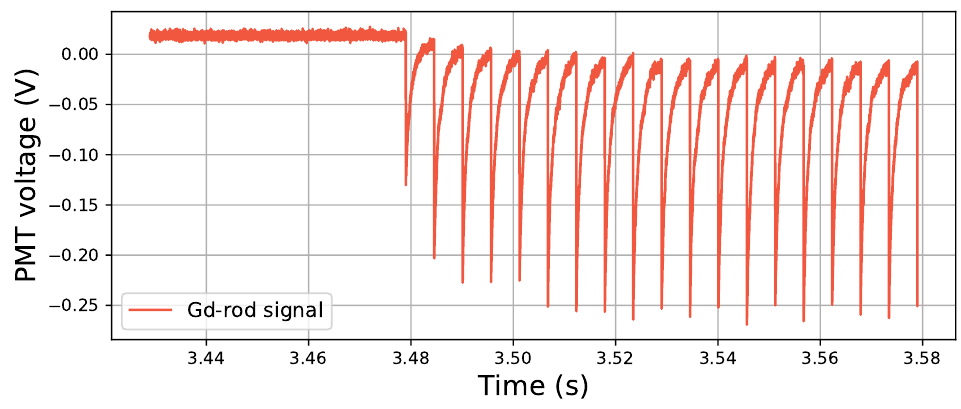
Figure 12. Signal from the Gd-doped sample when subjected to a pulsed beam with a frequency of 200 Hz at 1 mGy/bunch. The signal does not have time to fall back to the baseline, and the consecutive pulses are located on the tails of the previous ones.